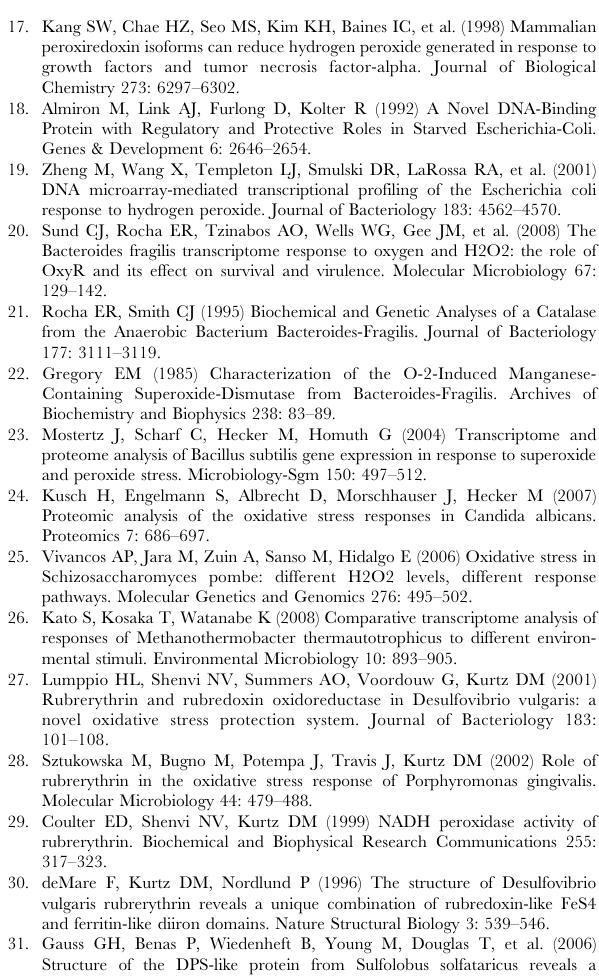
Table S1 Sulfolobus Solfataricus regulated genes